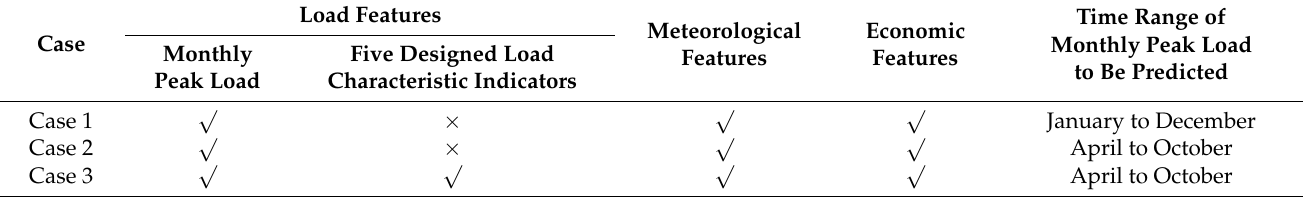
Table 3. In Case 1, in terms of input load features, historical monthly peak load was considered to be the input load variable without adding the other five designed load characteristic indicators listed in Table 1 for predicting the monthly peak load for all months in the coming year. In Case 2, we used the same input variables as the model in Case 1, but only the monthly peak loads with large load magnitudes from April to October are predicted by the model in this case. In Case 3, in addition to the monthly peak load, meteorological, and economic features used in Case 2, the other five load characteristic indicators were introduced to the input load features for forecasting the monthly peak load for the same month in Case 2. Table 3. Details of each case study.